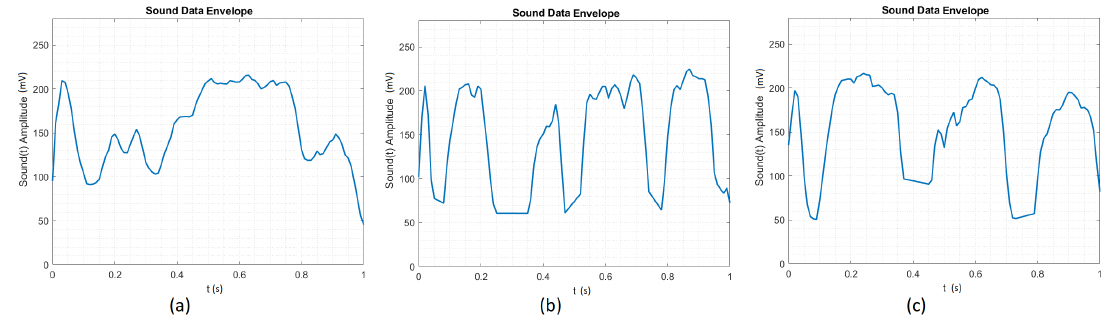
Figure 6. ( a ) Time scaled envelope signal for Circle. ( b ) Time scaled envelope signal for Square. ( c ) Time scaled envelope signal for